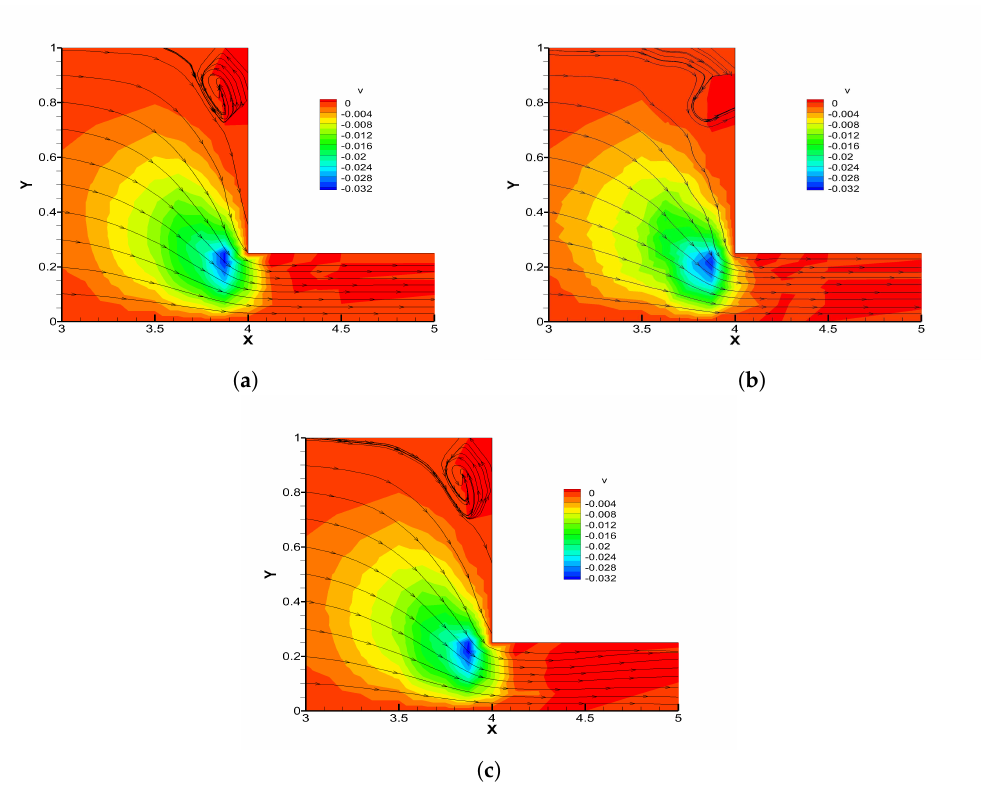
Figure 5. Streamlines and magnitude of the velocity u with different elements. From left to right: ( a ) P 1 b - P 1- P 1, standard, ( b ) P 1- P 1- P 1 without stabilization and ( c ) P 1- P 1- P 1 for the lowest equal order stabilized